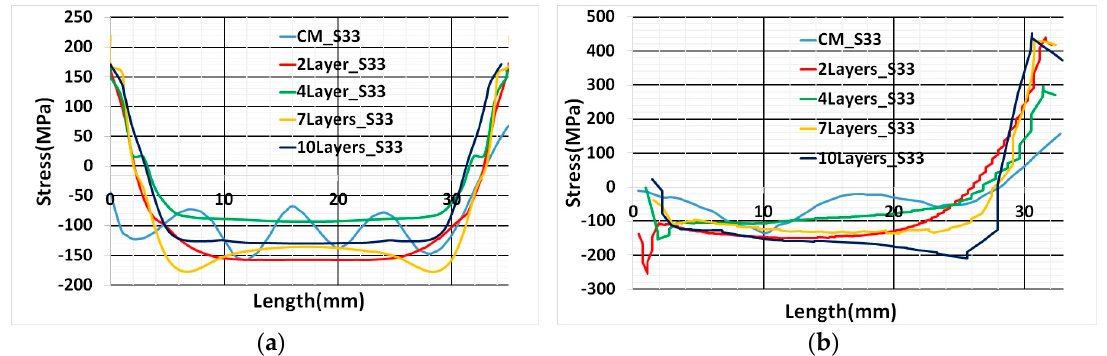
Figure 22. ( a ) Residual stress in the Path-1 comparison with contour method; ( b ) Residual stress comparison in the Path-2.